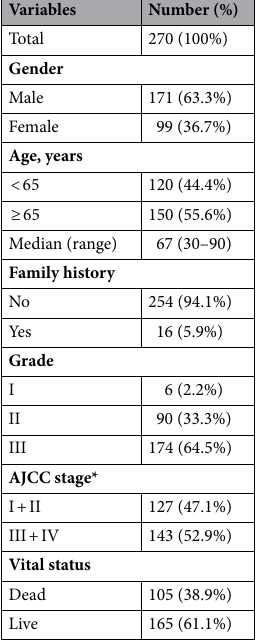
Table 1. Baseline Information of STAD Patients without Distant Metastasis. *According to the sixth edition of AJCC staging system for gastric